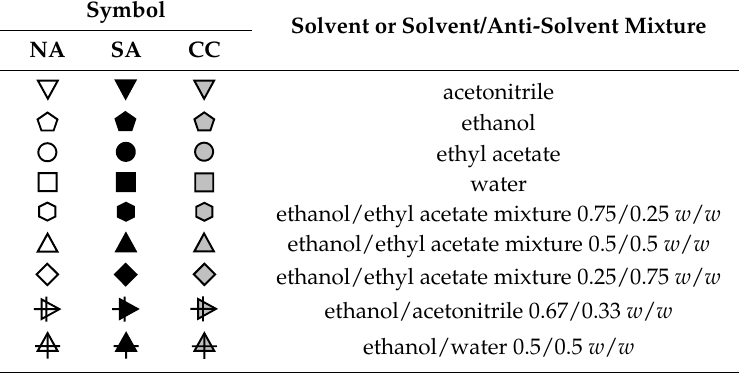
Table 5. List of symbols that refer to solubility points measured in a specific solvent or solvent/anti-solvent mixture with nicotinamide (NA), succinic acid (SA) or the cocrystal (CC) in the corresponding solid phases.